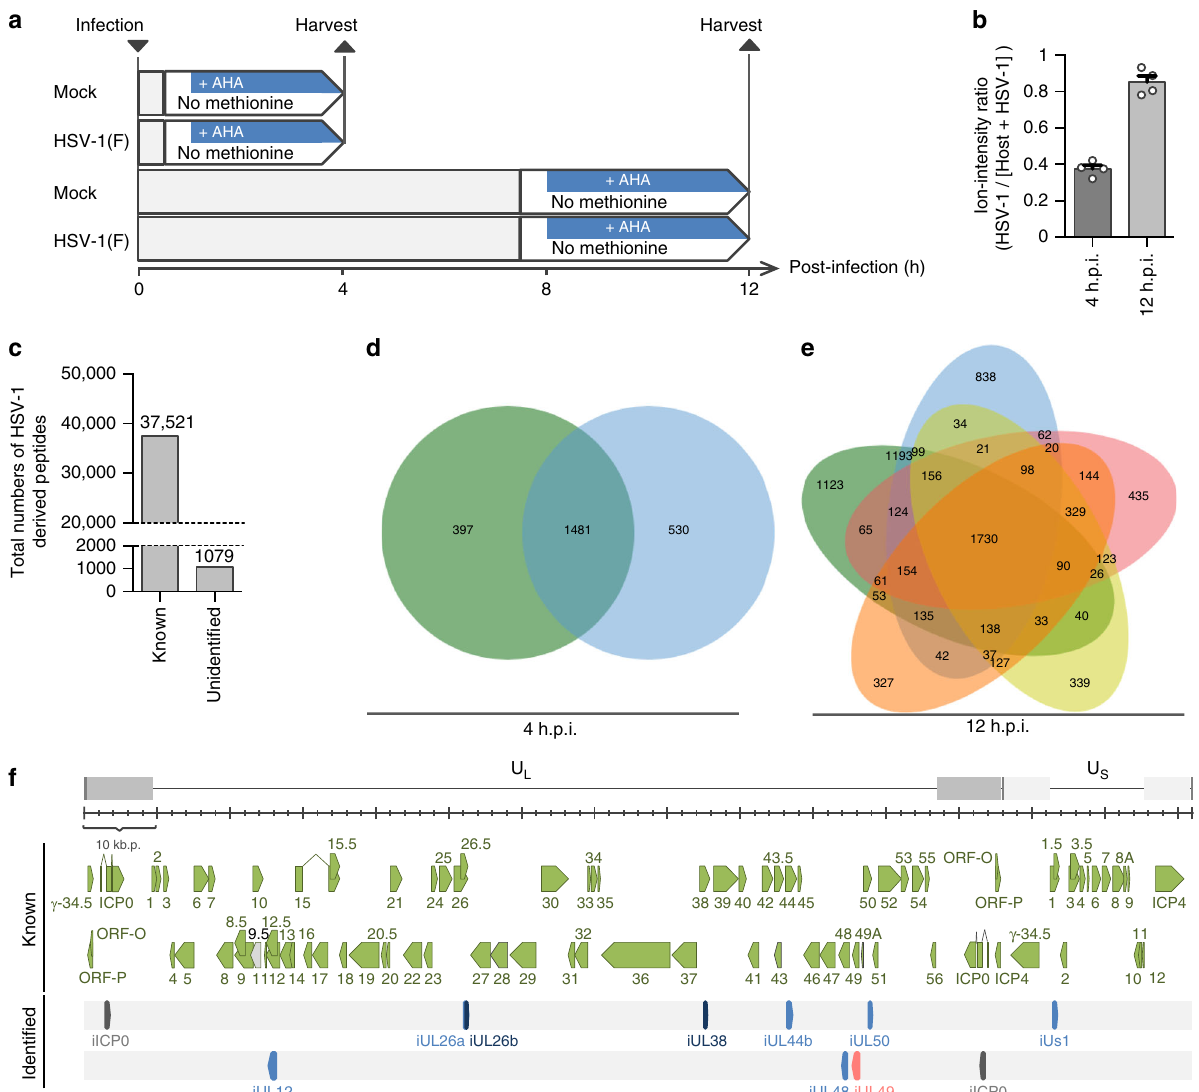
Fig. 1 Identi fi cation of previously unidenti fi ed HSV-1 CDSs by B chemical proteomics. a Diagram illustrating the procedure of AHA labeling experiments for BONCAT-based MS-analyses ( n = 2). In each of the two experiments, MS-analyses were performed twice. b Ion-intensity of viral polypeptides relative to that of viral and host polypeptides. Each value is the mean ± SEM of four MS-analyses. c Total numbers of peptides detected in HSV-1-infected cells at 4 h and 12 h post-infection and mapped to known or previously unidenti fi ed HSV-1 CDSs in the experiments shown in Fig. 1a and Supplementary Fig. 1a. The number is shown above the bars. d Venn diagrams showing the results of two independent AHA-labeling experiments by 4 h post-infection using wild- type HSV-1(F)-infected cells as described in Fig. 1a. The numbers indicate the number of peptides derived from HSV-1 CDSs. e Venn diagrams showing the results of fi ve independent AHA-labeling experiments by 12 h post-infection using wild-type HSV-1(F) infected cells as described in Fig. 1a ( n = 2) and Supplementary Fig. 1a ( n = 3). The numbers indicate the number of peptides derived from HSV-1 CDSs. f Schematic diagram of the genome of wild-type HSV-1 and the map of HSV-1 CDSs known and identi fi ed in this study. Source data are provided as a Source Data fi